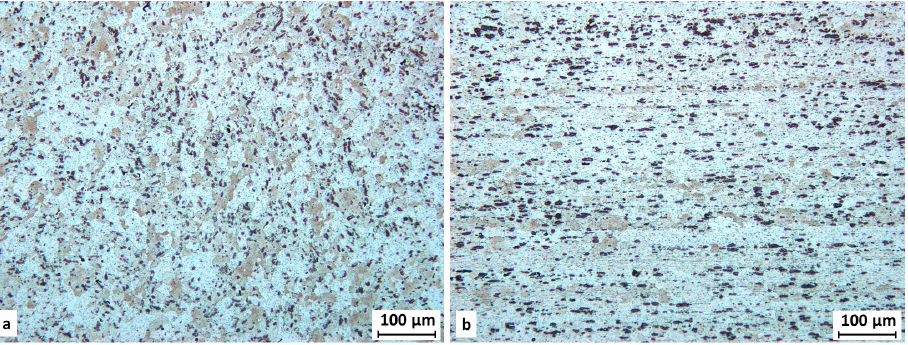
Figure 15. Microstructure of extruded material; ( a ) transverse direction; ( b ) longitudinal direction. Materials 2018 , 10 , x FOR PEER REVIEW